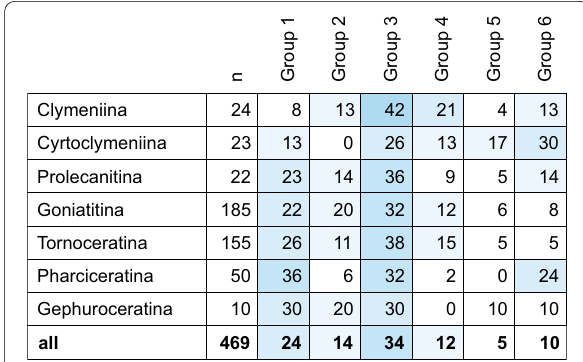
Fig. 6 Percentages of the six distinguished groups with different modes of septal distance in six Devonian and Carboniferous ammonoid